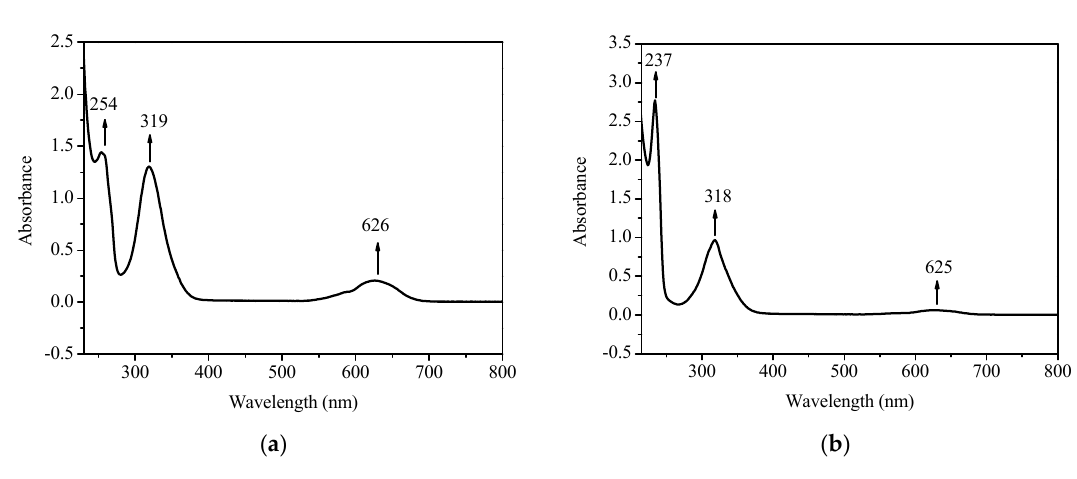
Figure 6. UV-Vis spectra of 1 ( a ) and 2 ( b ) in MeCN.